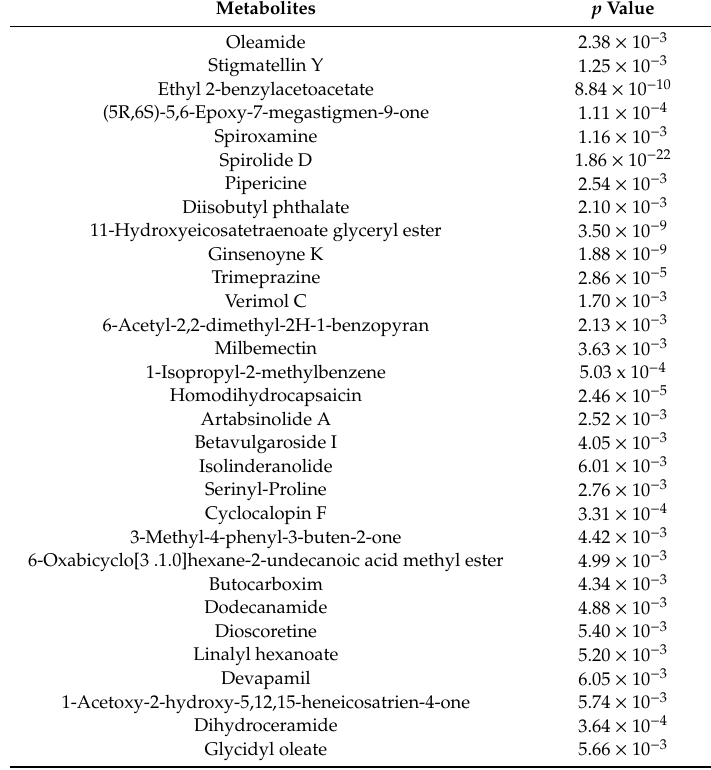
Table 1. List of Upregulated Metabolites in Ranibizumab-Treated HTFs Compared to Control HTFs. At a p -value < 0.01 with a cut o ff value of two-fold change, 31 metabolites were significantly upregulated in the ranibizumab-treated HTFs group compared to the HTFs control